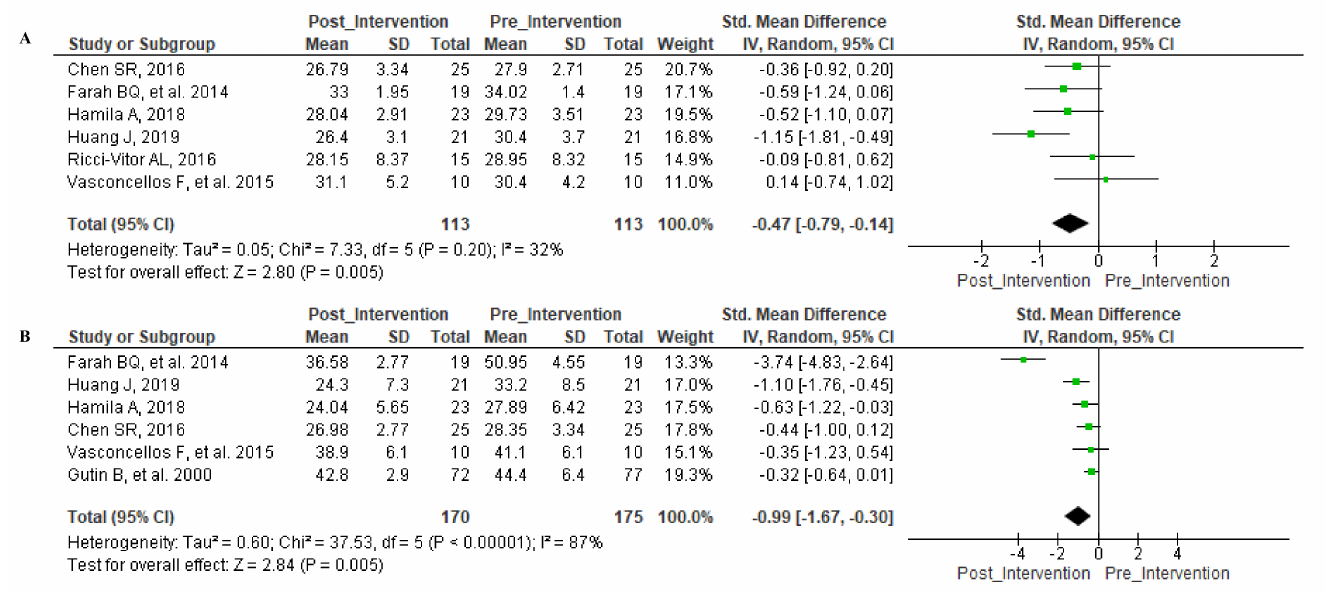
Figure 5. Forest Plot—Secondary parameters. Legend—( A ): BMI; ( B ):